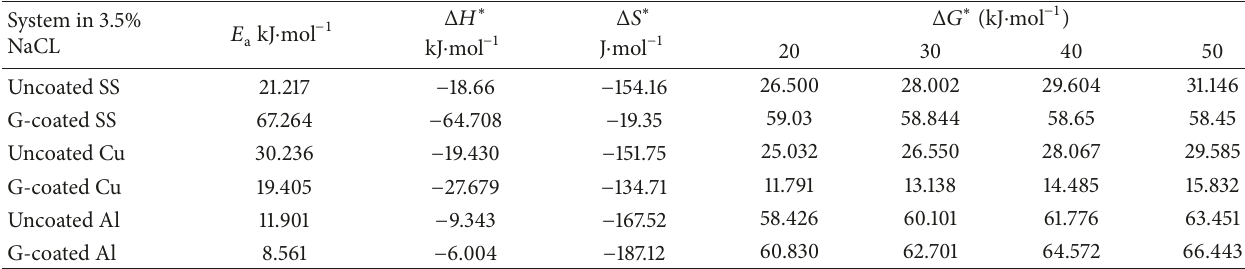
Table 2: The calculated thermodynamic functions, 𝐸 a , Δ𝐻 ∗ , Δ𝑆 ∗ , and Δ𝐺 ∗ , for the corrosion process of the uncoated and reduced GO coated SS, Cu, and Al in seawater. System in